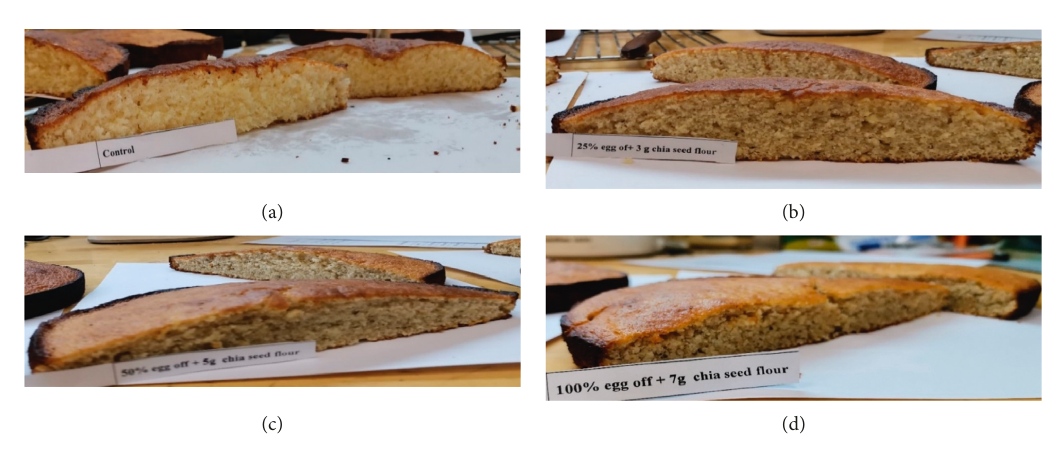
Figure 1: Photograph of cakes. (a) CSF0. (b) CSF3. (c) CSF5. (d) CSF7.